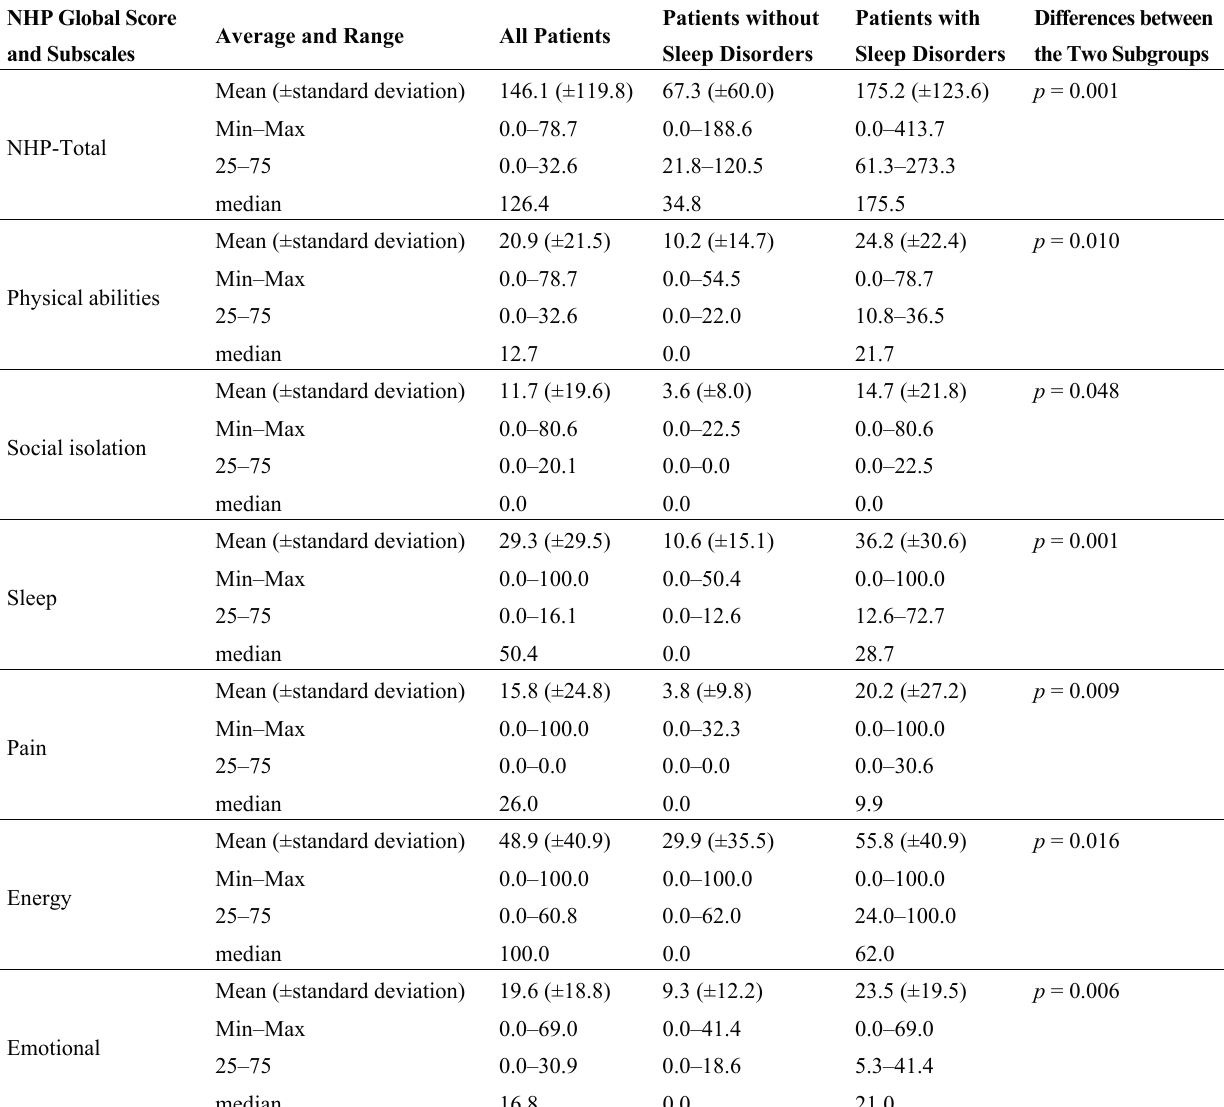
Table 1. NHP values in patients with and without sleep